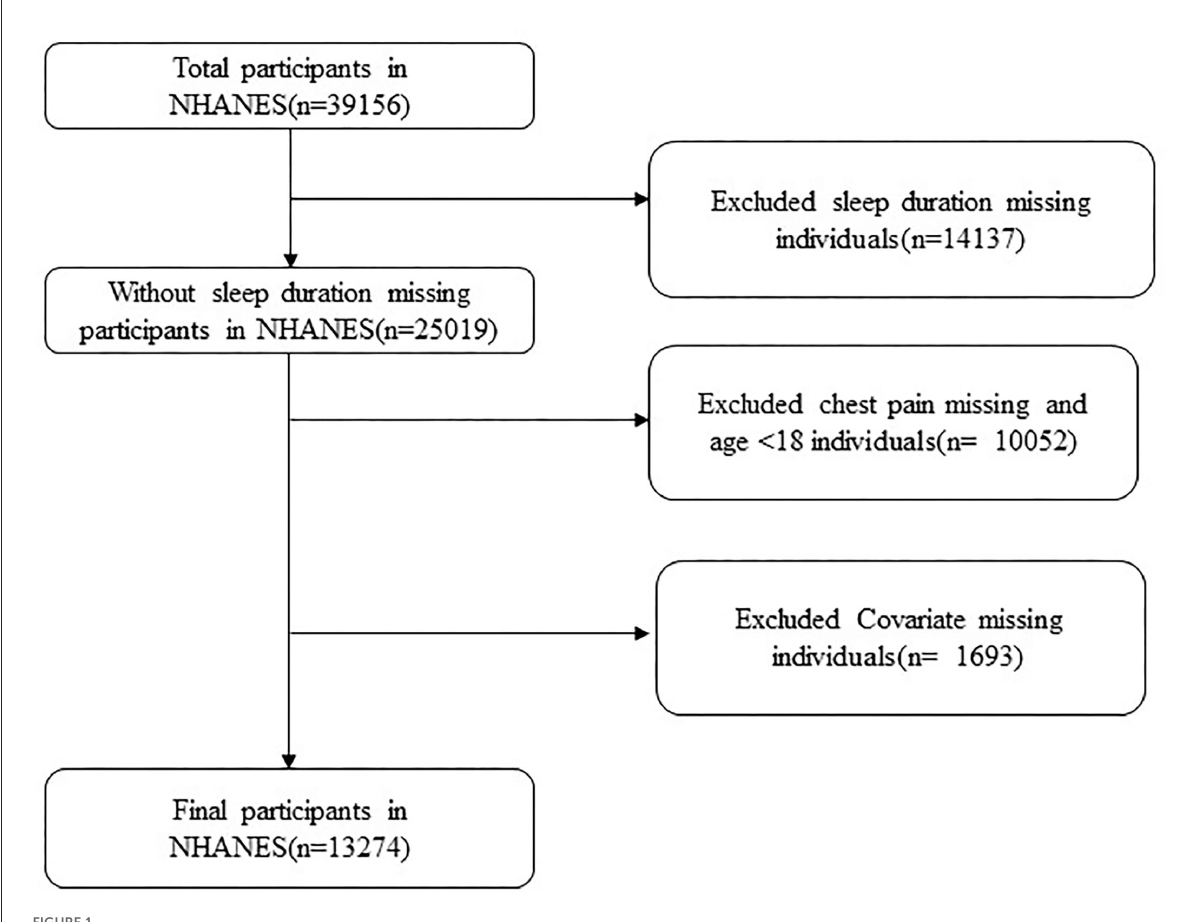
FIGURE1 Flow chart of patient